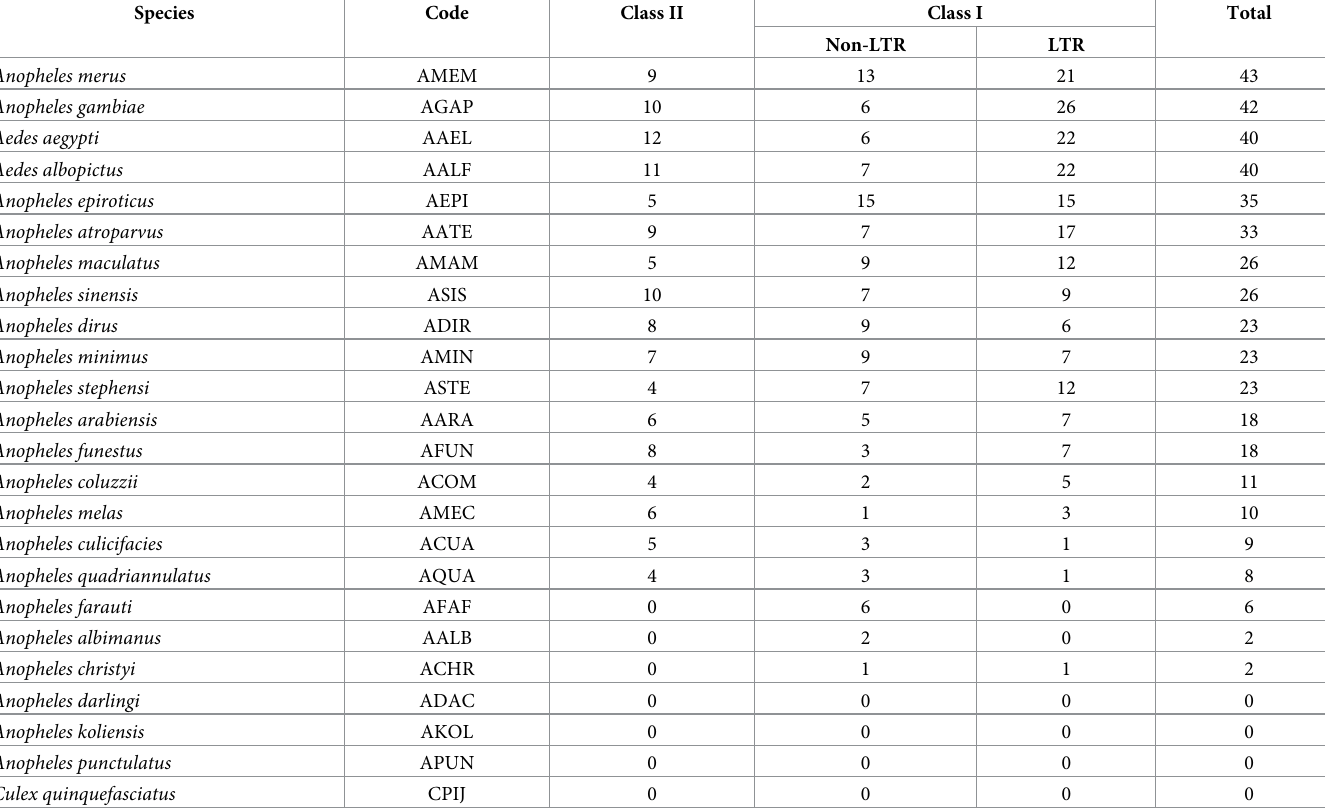
TE families of this superfamily involved in HTT occurred between more than 2 mosquito spe- cies. Details about the participation of species in each TE family horizontal transfer network can be seen in S2 File, which lists all VHICA output images of positive HTT cases. The relative intragenomic age of each TE family undergoing HT per mosquito genome is given in S5 Fig. Horizontal transposon transfers directly impact the genome size of mosquitoes TEs horizontally transferred between species represent a significant fraction of some mosquito genomes (Fig 4A). We estimated that about 6.7% of Ae . aegypti and 7.8% Ae . albopictus genomes are covered by horizontally transferred TEs representing more than 10% of the total TE content of these species. In the Anopheles genus, the impact of horizontal transfer on genome size was considerably smaller. Only An . gambiae , An . coluzzii , and An . stephensi showed more than 1% of their genome covered with copies derived from horizontally trans- ferred TEs. The proportion of genome covered by horizontally transferred TEs showed a positive corre- lation with the genome size of the host species Fig 4B. Therefore, TE invasion by way of Table 1. Number of TE families in each species that is involved in HTT events. Species